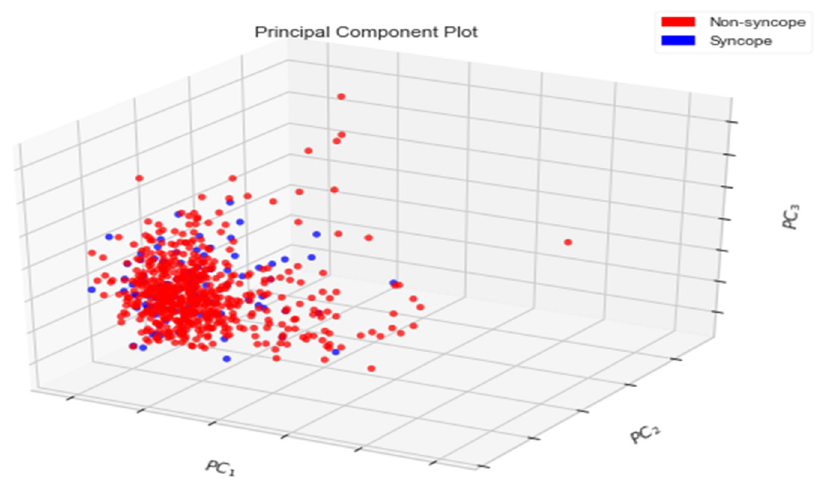
Figure 8. Three-Dimensional Plot of First Three PCs.